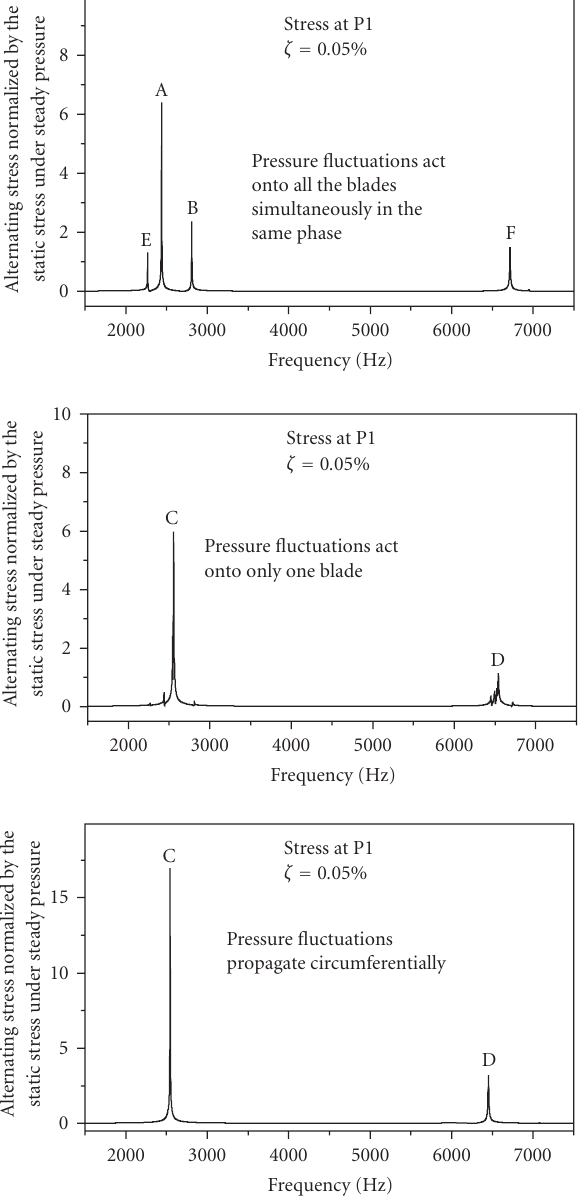
Figure 16: Responses under di ff erent pressure excitations (FEM